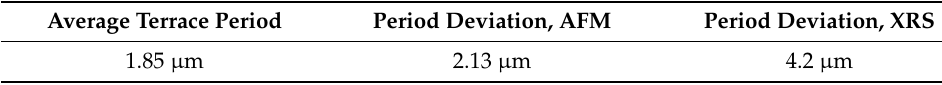
Figure 3. Roughness PSD functions from X-ray scattering measurements plotted against spatial frequency. Colored markers and lines represent the data obtained from the surface of polished (green, blue) and annealed (red, black) specimens with scintillation (circles) and position sensitive (squares) detectors. The solid magenta line defines PSD function calculated from AFM data for the polished surface. Table 1. Area-averaged period of terrace-stepped relief.